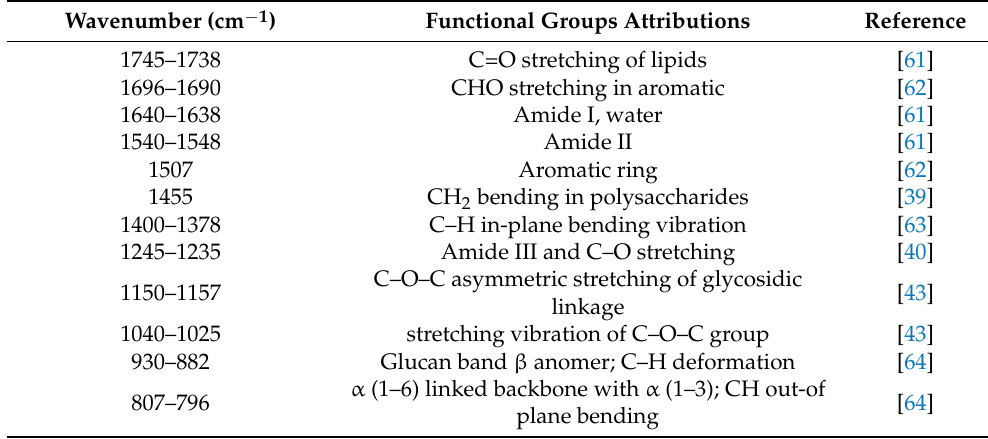
Table 3. Attributions of the main characteristic FT-IR bands in the spectra of G. lucidum , L. edodes and P. cornucopiae fruiting bodies according to the